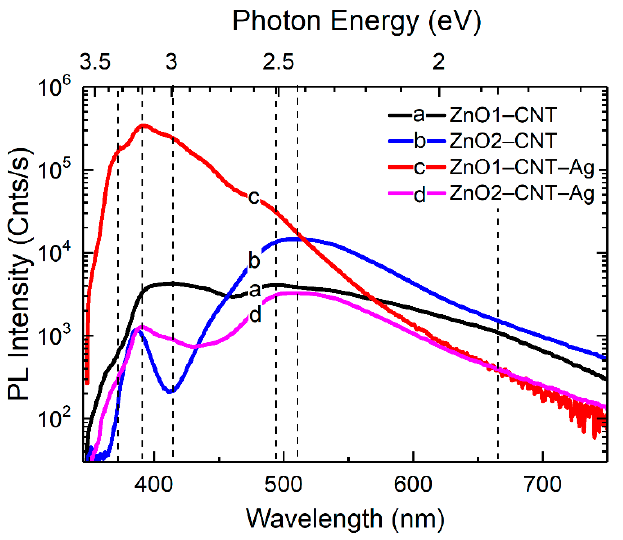
Figure 6 . PL spectra at 300 K of (a) ZnO1–CNT, (b) ZnO2–CNT, (c) ZnO1–CNT–Ag and (d) ZnO2– CNT–Ag.